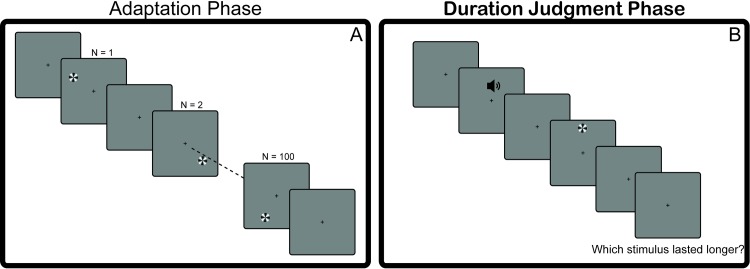
An overview of the experimental procedure for the adaptation experiment.Adaptation Phase (A): participants adapted to 100 repetitions of one of three adaptation stimuli: an illusion-inducing rotating radial grating (300 ms, 8.33Hz), a static radial grating matched to the onset-offset duration of the illusion-inducing stimulus (300 ms, static), or a static grating matched to the perceived duration of the illusion-inducing stimulus (Mduration = 572.60, static). Duration Judgment Phase (B): participants completed a duration judgment task in which they compared the duration of an auditory reference to that of a static visual test stimulus.